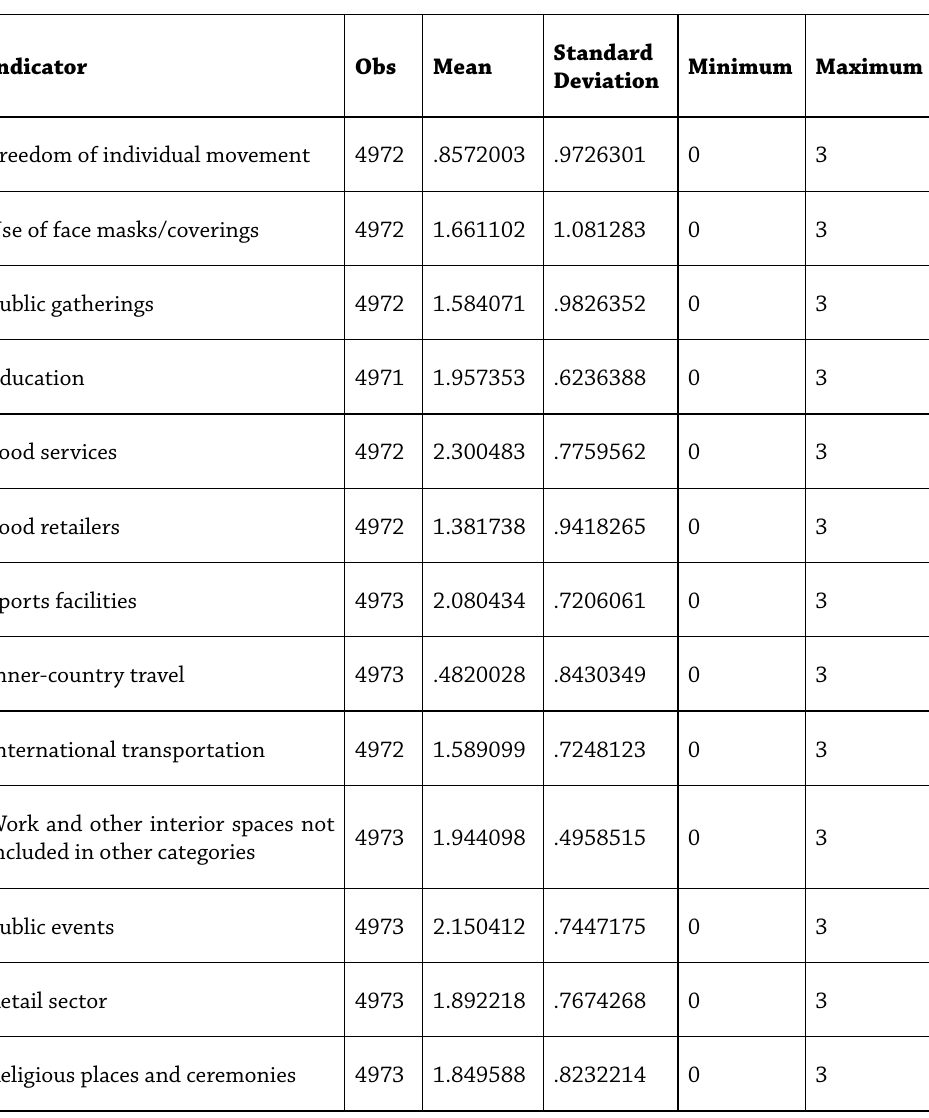
Table 2: Descriptive Statistics of